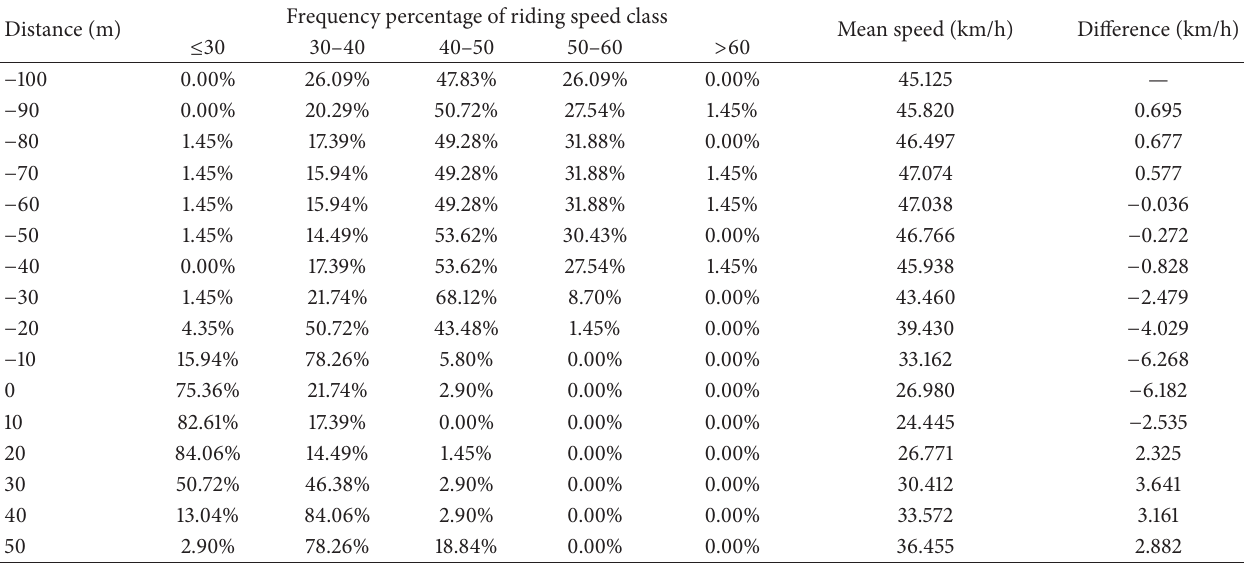
brake intensity class had become the dominant group as the frequency values were found as 46.38% and peaked at the point − 10 m, where 97.10% riders were found to apply brake value within this class. After they ride past the speed table, it is logic that most riders were no longer found to apply brake force and the brake intensity applied had drop back to below 20%. Taking together the observation and analysis